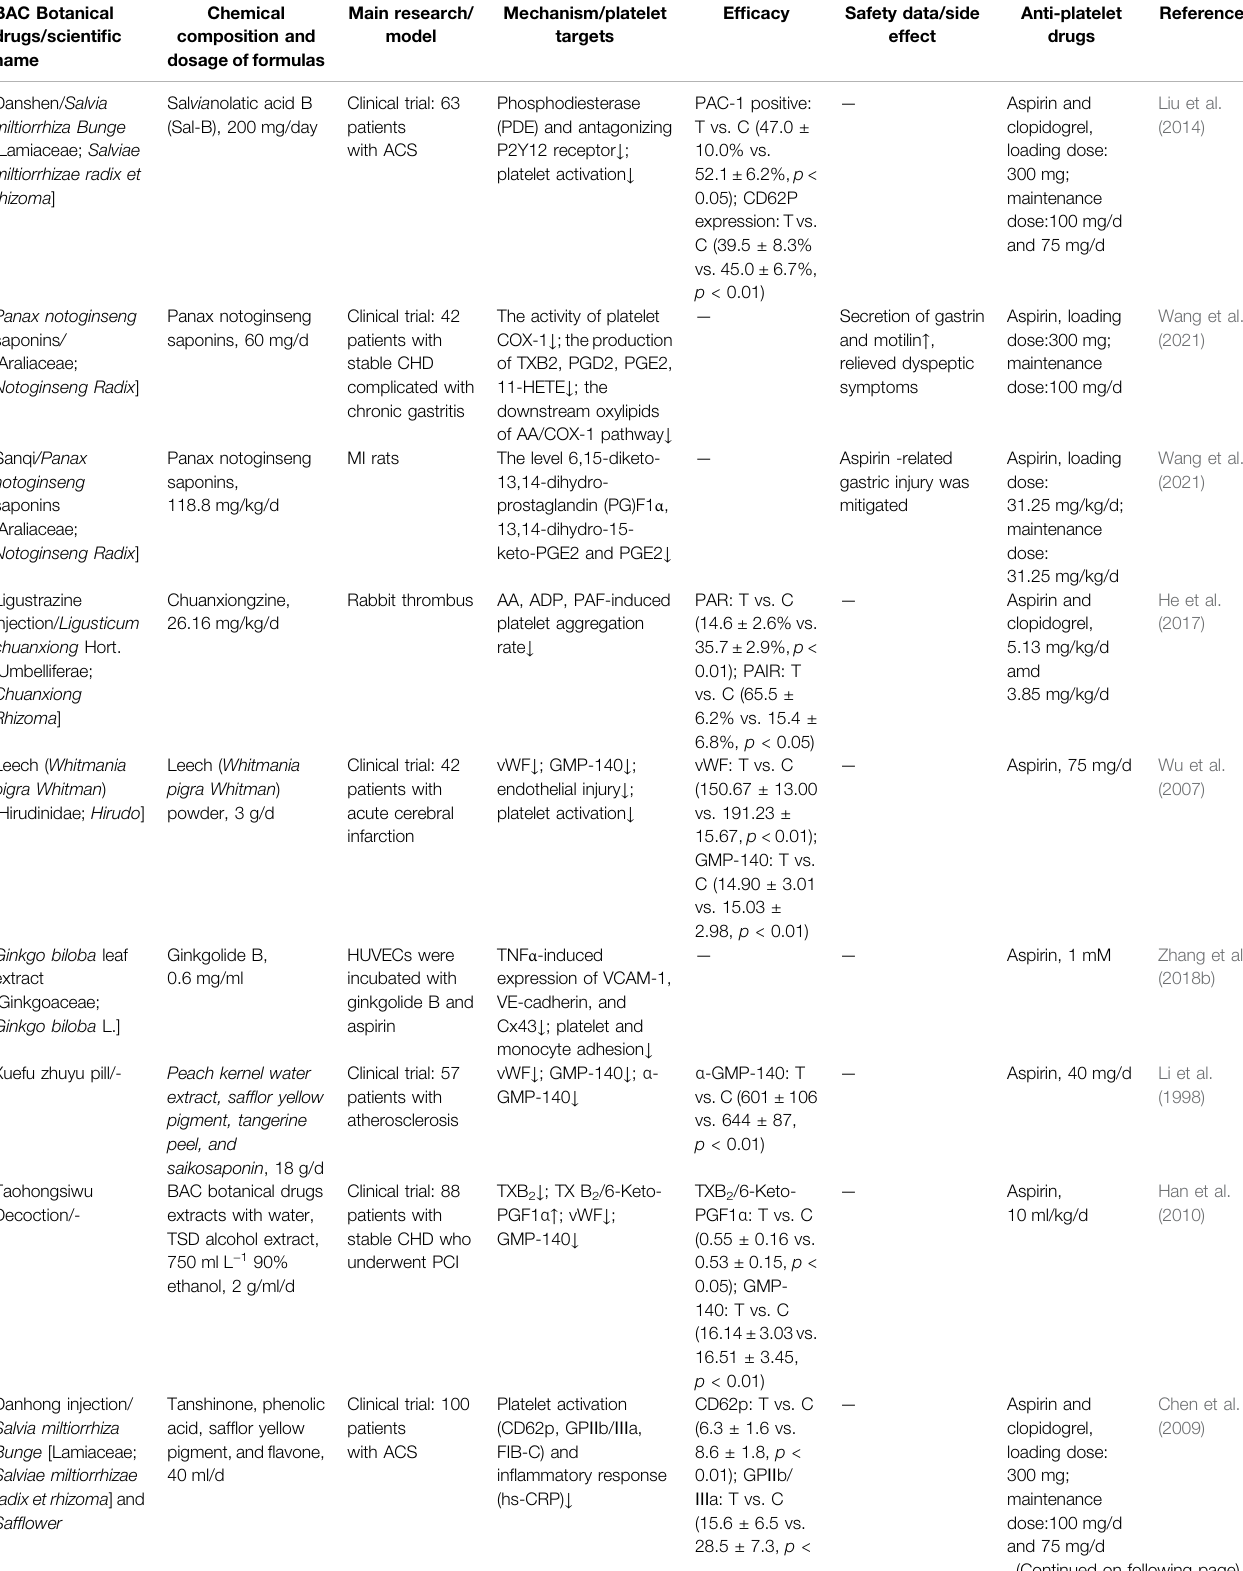
TABLE 1 | Research on anti-platelet drugs combined with BAC botanical